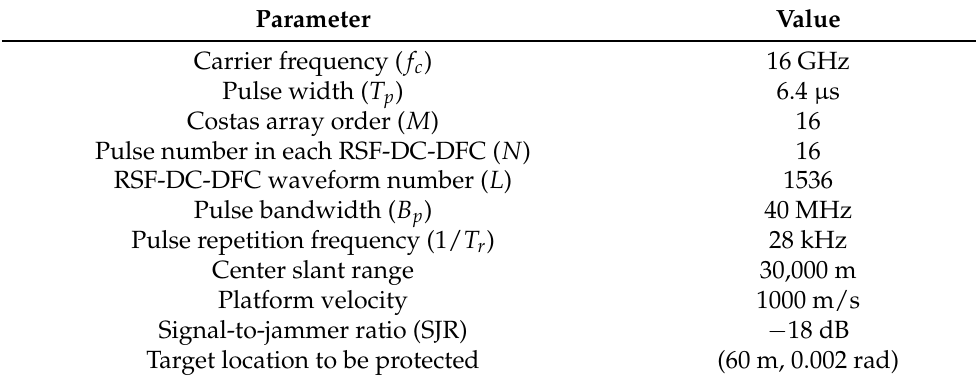
Table 2. Simulation